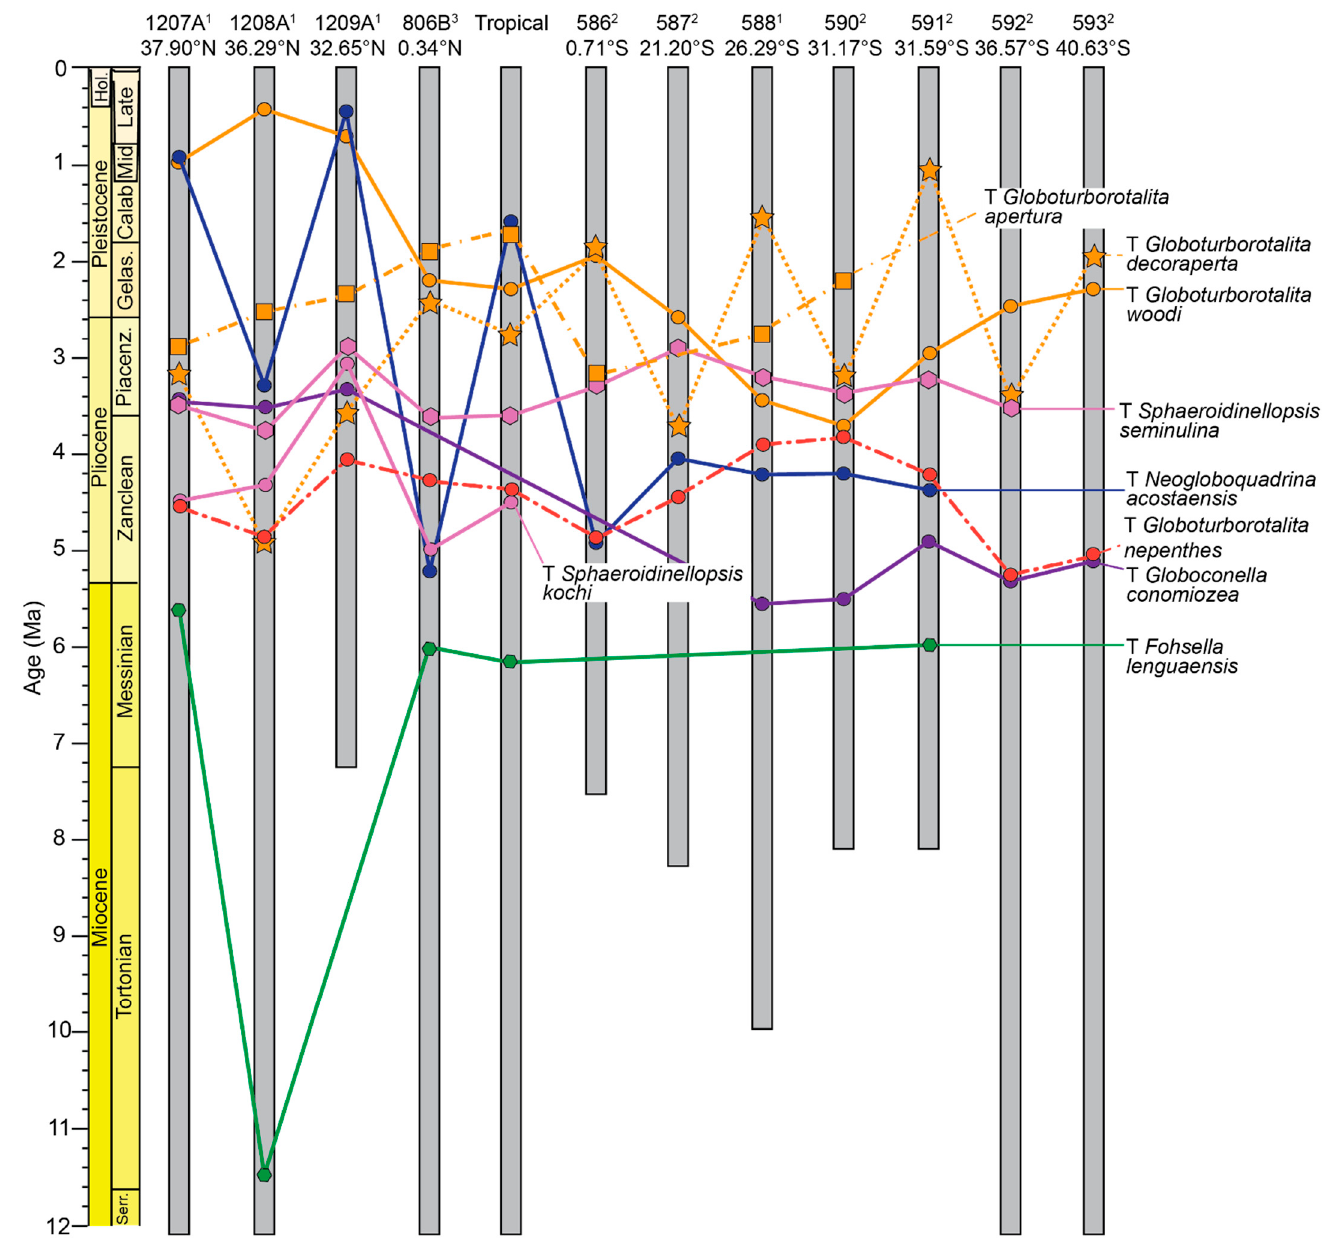
Figure 6. Last occurrences of species used as primary and secondary datums in tropical-to-mid- latitude biostratigraphic zonations belonging to the genera Globoturborotalita, Sphaeroidinellopsis , Neogloboquadrina , Globoconella , and Fohsella . Sites are ranked 1–3, as denoted by the superscript number beside each site number. A ranking of 1 indicates that the sites’ age model is based solely on magnetostratigraphy, a ranking of 2 indicates that the sites’ age model is a mix of magnetostratigraphy and biostratigraphy, and a ranking of 3 indicates that the sites’ age model is based solely on biostratigraphy (Supplementary Table S1).